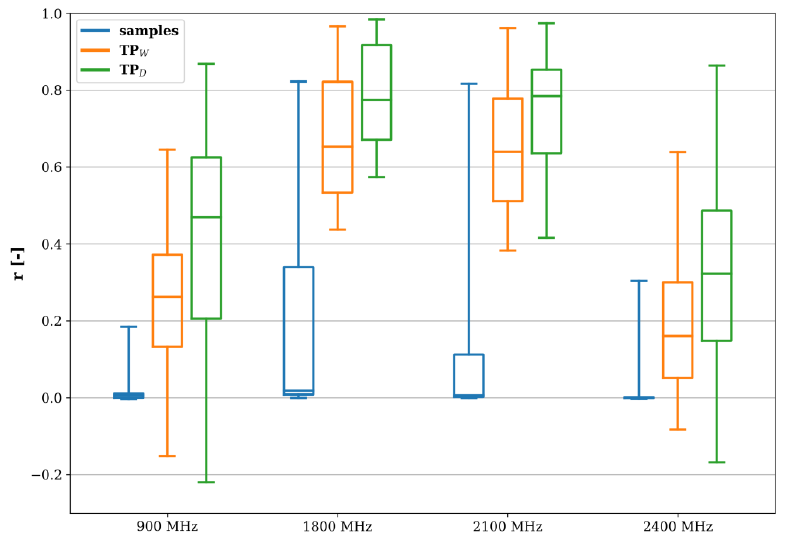
Figure 12. Boxplots showing the median and the range of the Pearson correlation coefficients per frequency band between the differentiated time series measured by the fixed RF-EMF sensors denoted as ‘samples’, ‘TP D ’ (daily temporal profile), and ‘TP W ’ (weekly temporal profile).